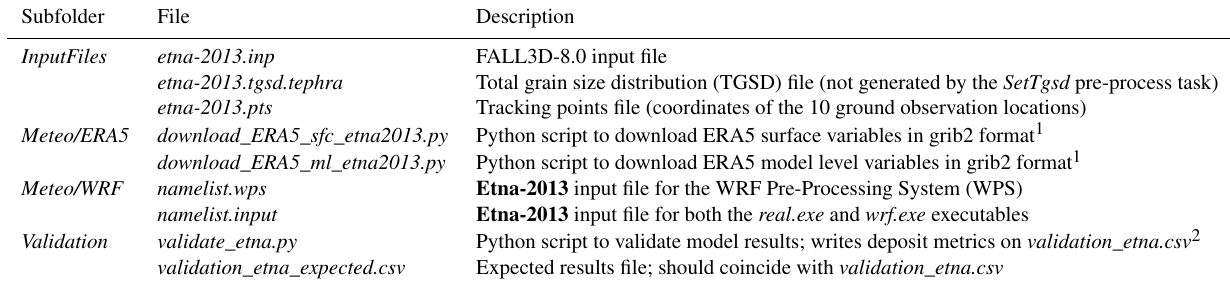
Table 3. Description of the files in the Etna-2013 test suite folder (see Sect. 3.3).